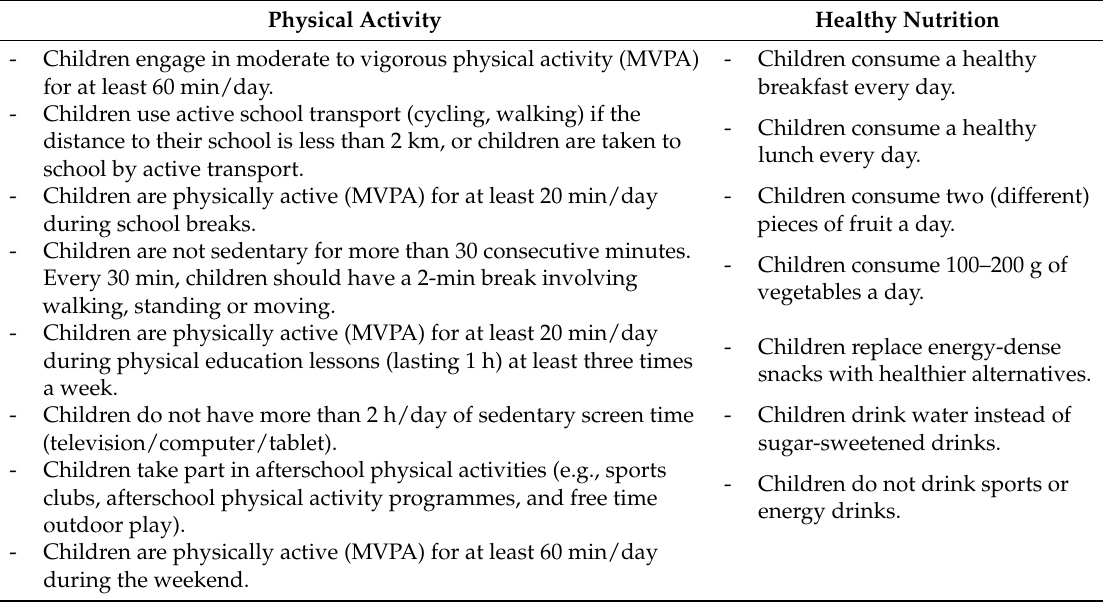
Table 2. Behavioural goals regarding physical activity and healthy